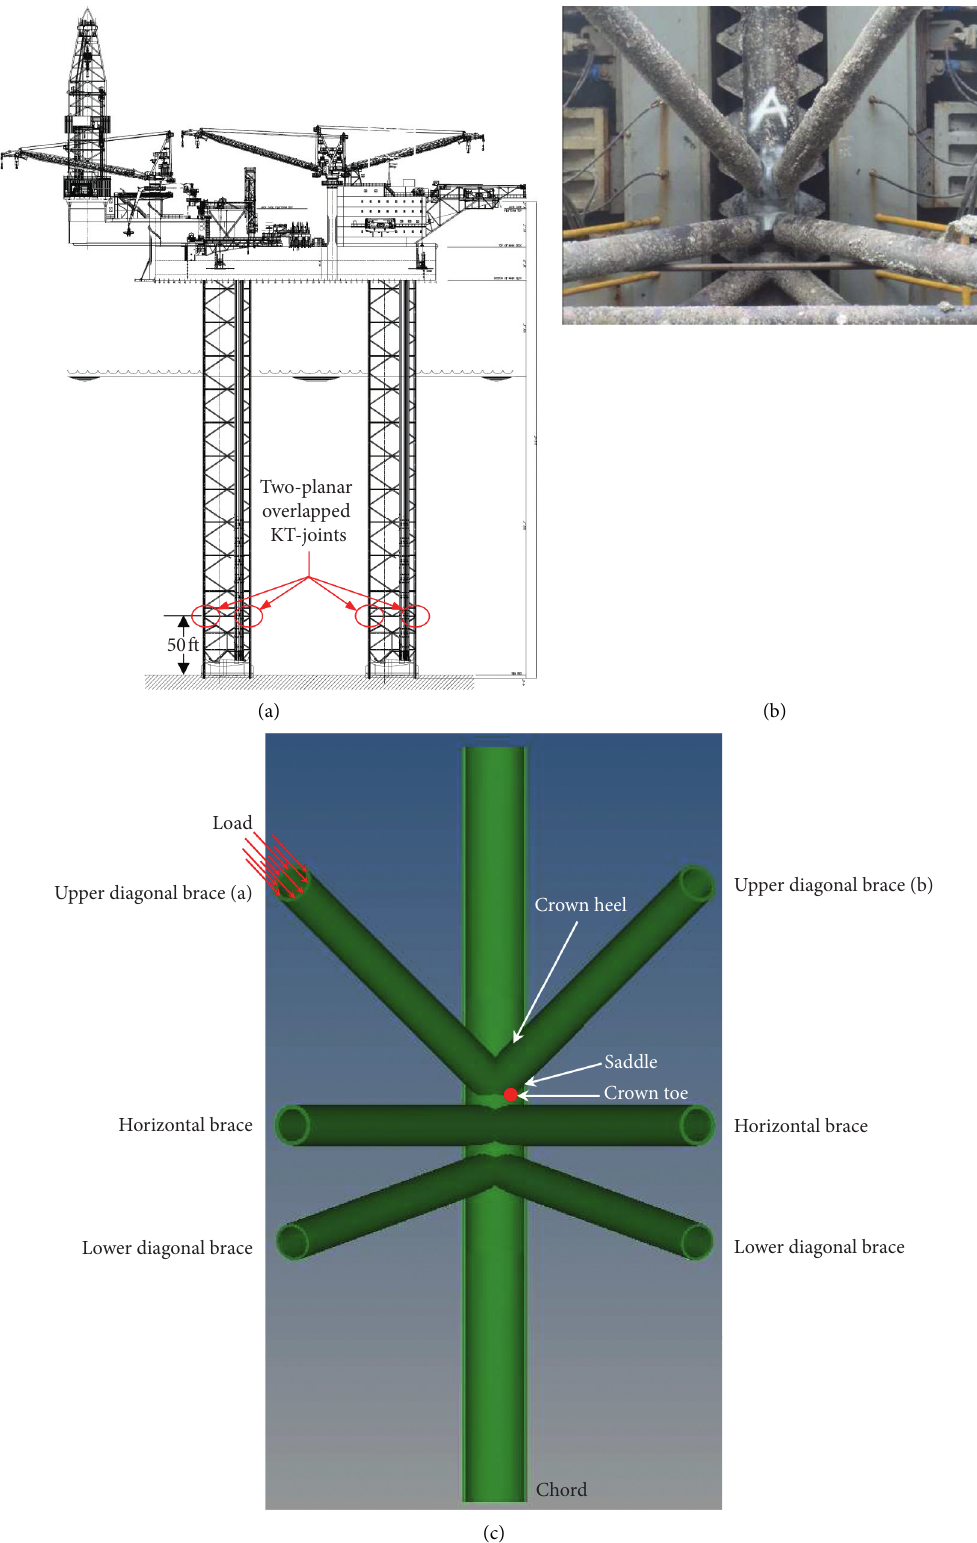
Figure 1: (a) A schematic jack-up, (b) a fabricated two-planar overlapped KT-joint, and (c) schematic diagram of a two-planar overlapped